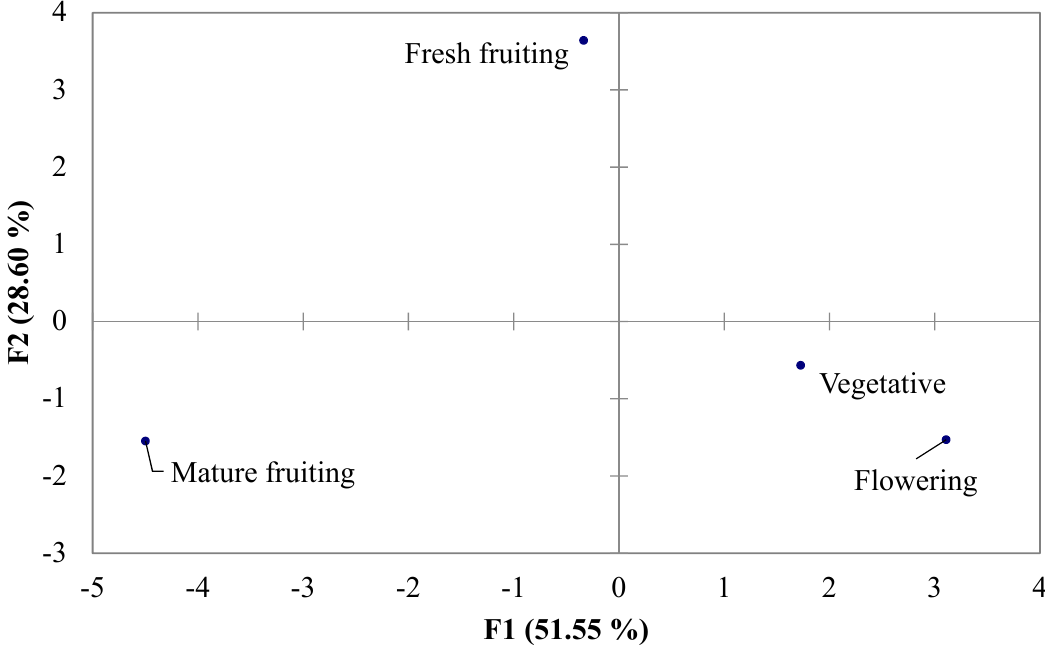
Figure 2. Principal components analysis of different stages based on the fatty acid composition of Retama raetam (Forssk.) Webb (Table 1).